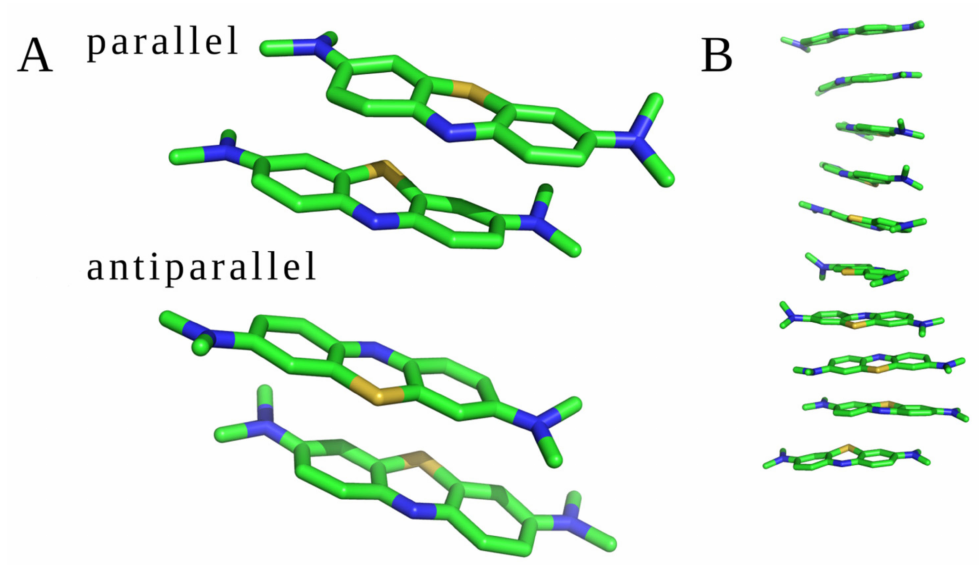
Figure 3. MB stacks observed in the MD simulations. ( A ) Two MB molecules in parallel and antiparallel orientations and ( B ) ten GAG-free MB (structures are displayed in stick representation; green—carbon atoms, blue—nitrogen atoms, and yellow—sulfur atoms).